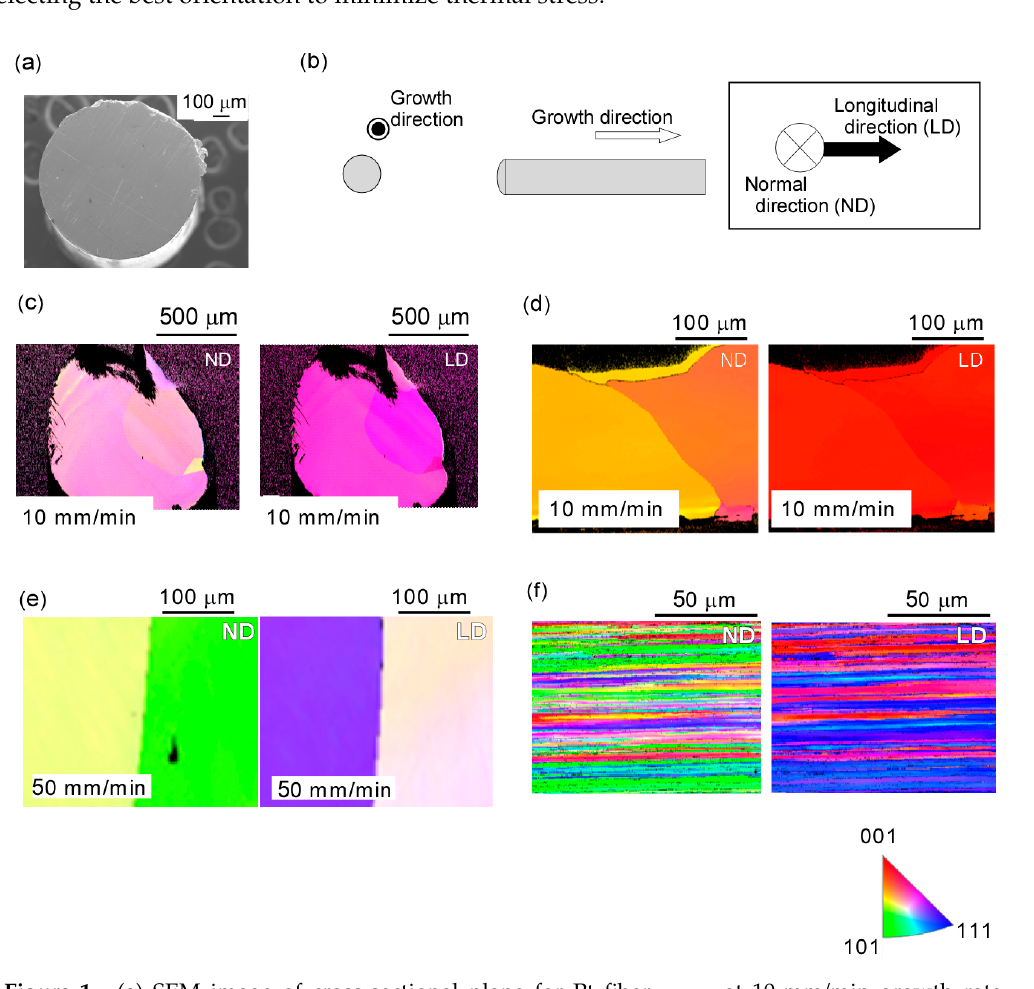
Figure 1. ( a ) SEM image of cross-sectional plane for Pt fiber A- µ -PD at 10-mm / min growth rate. ( b ) Schematic diagram of the relationship between specimens and each direction of SEM–EBSD analysis. IPF maps of Pt fiber A- µ -PD ; ( c ) Perpendicular to growth direction fabricated at 10-mm / min growth rate, and parallel to growth direction fabricated at ( d ) 10-mm / min and ( e ) 50-mm / min growth rates. ( f ) Longitudinal direction of Pt wire WDP .